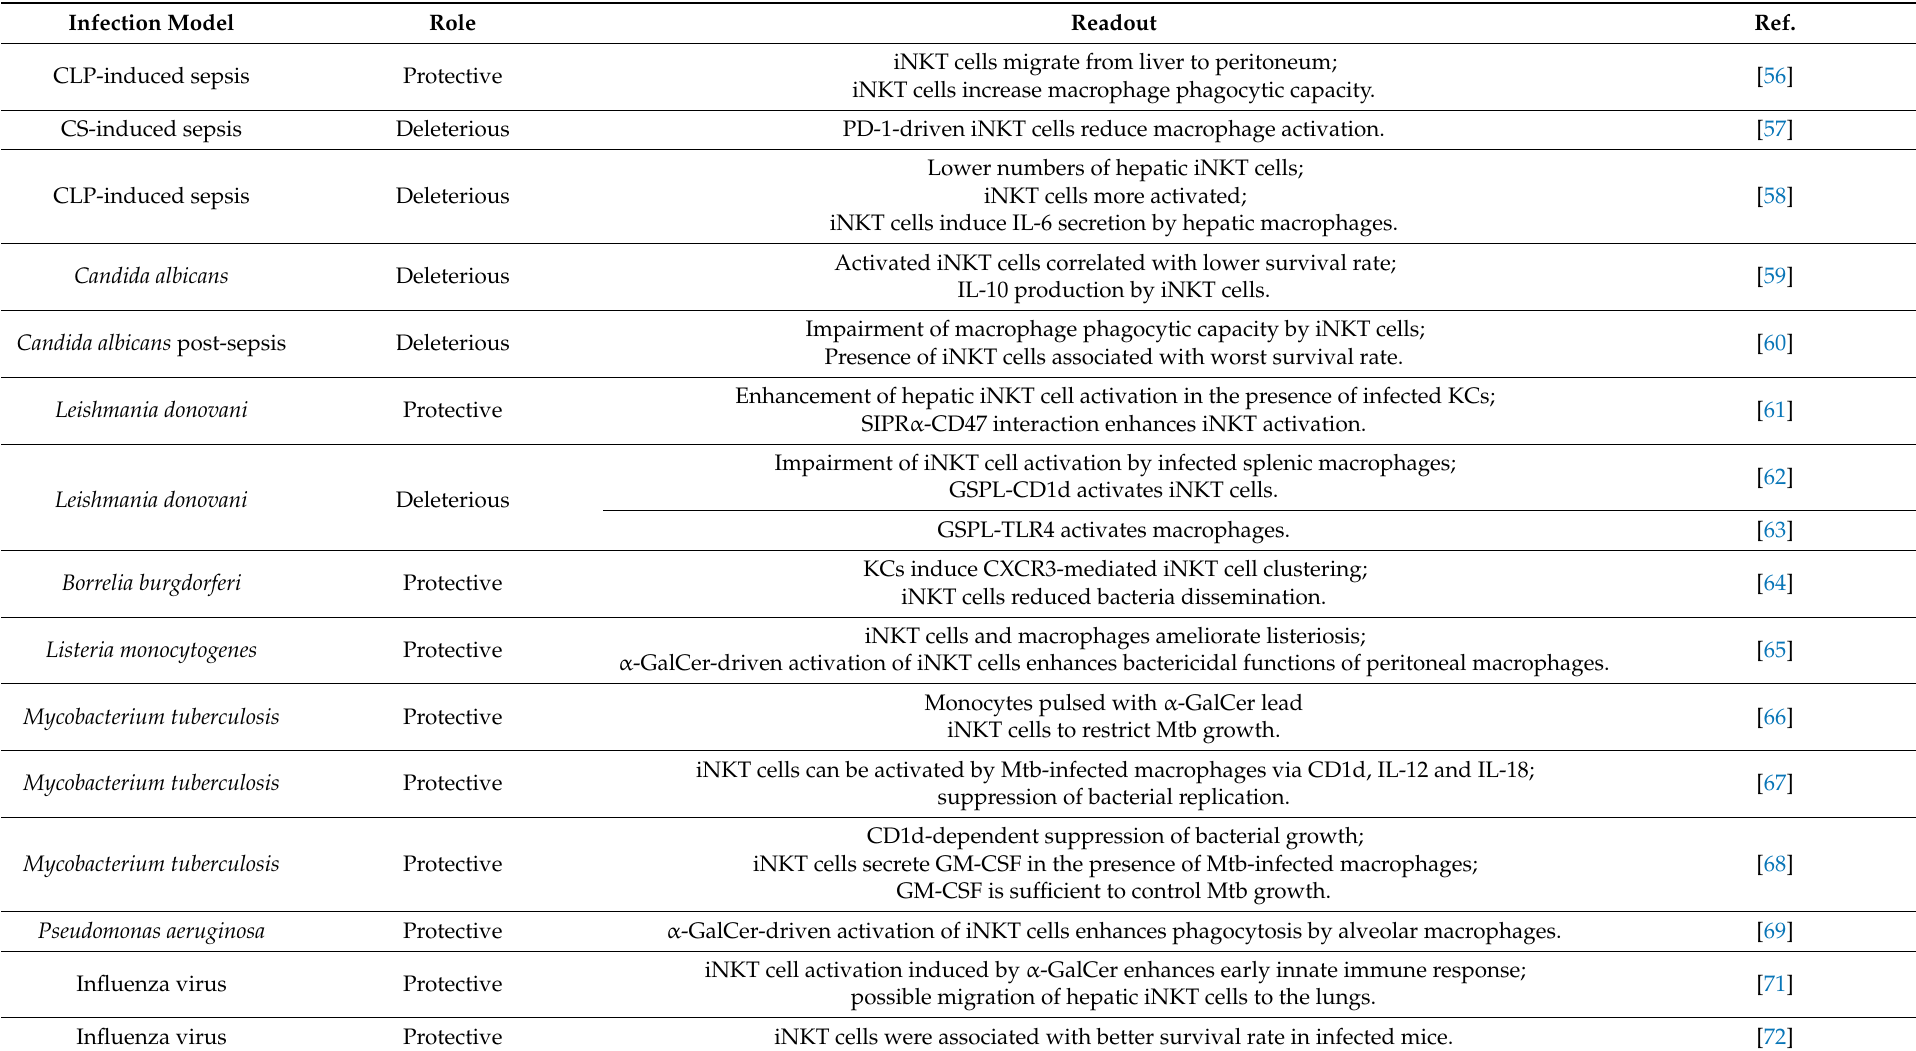
Table 1. Interaction between iNKT cells and macrophages in different contexts of